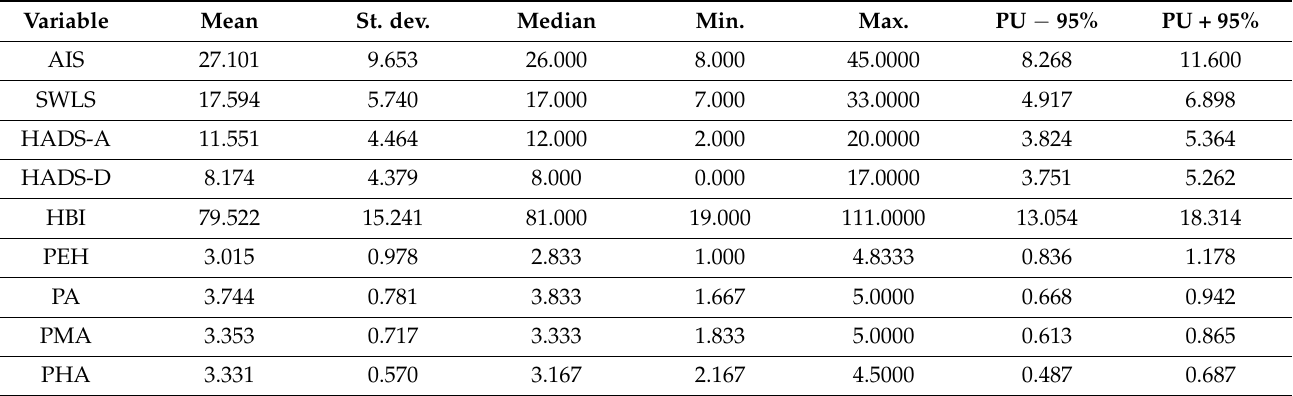
Table 2. Descriptive statistics of variables for the study group as a whole (N =